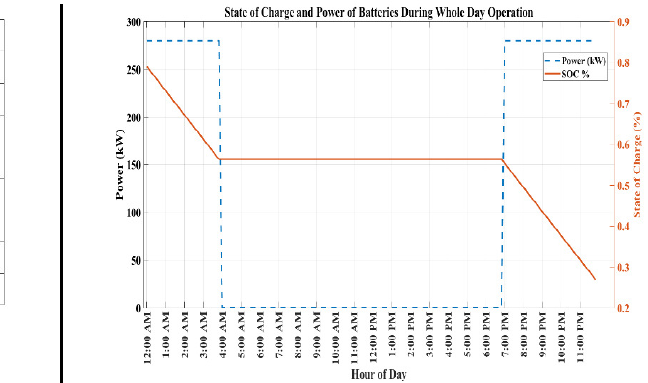
Fig. 14: Share of individual generation to meet the load demand